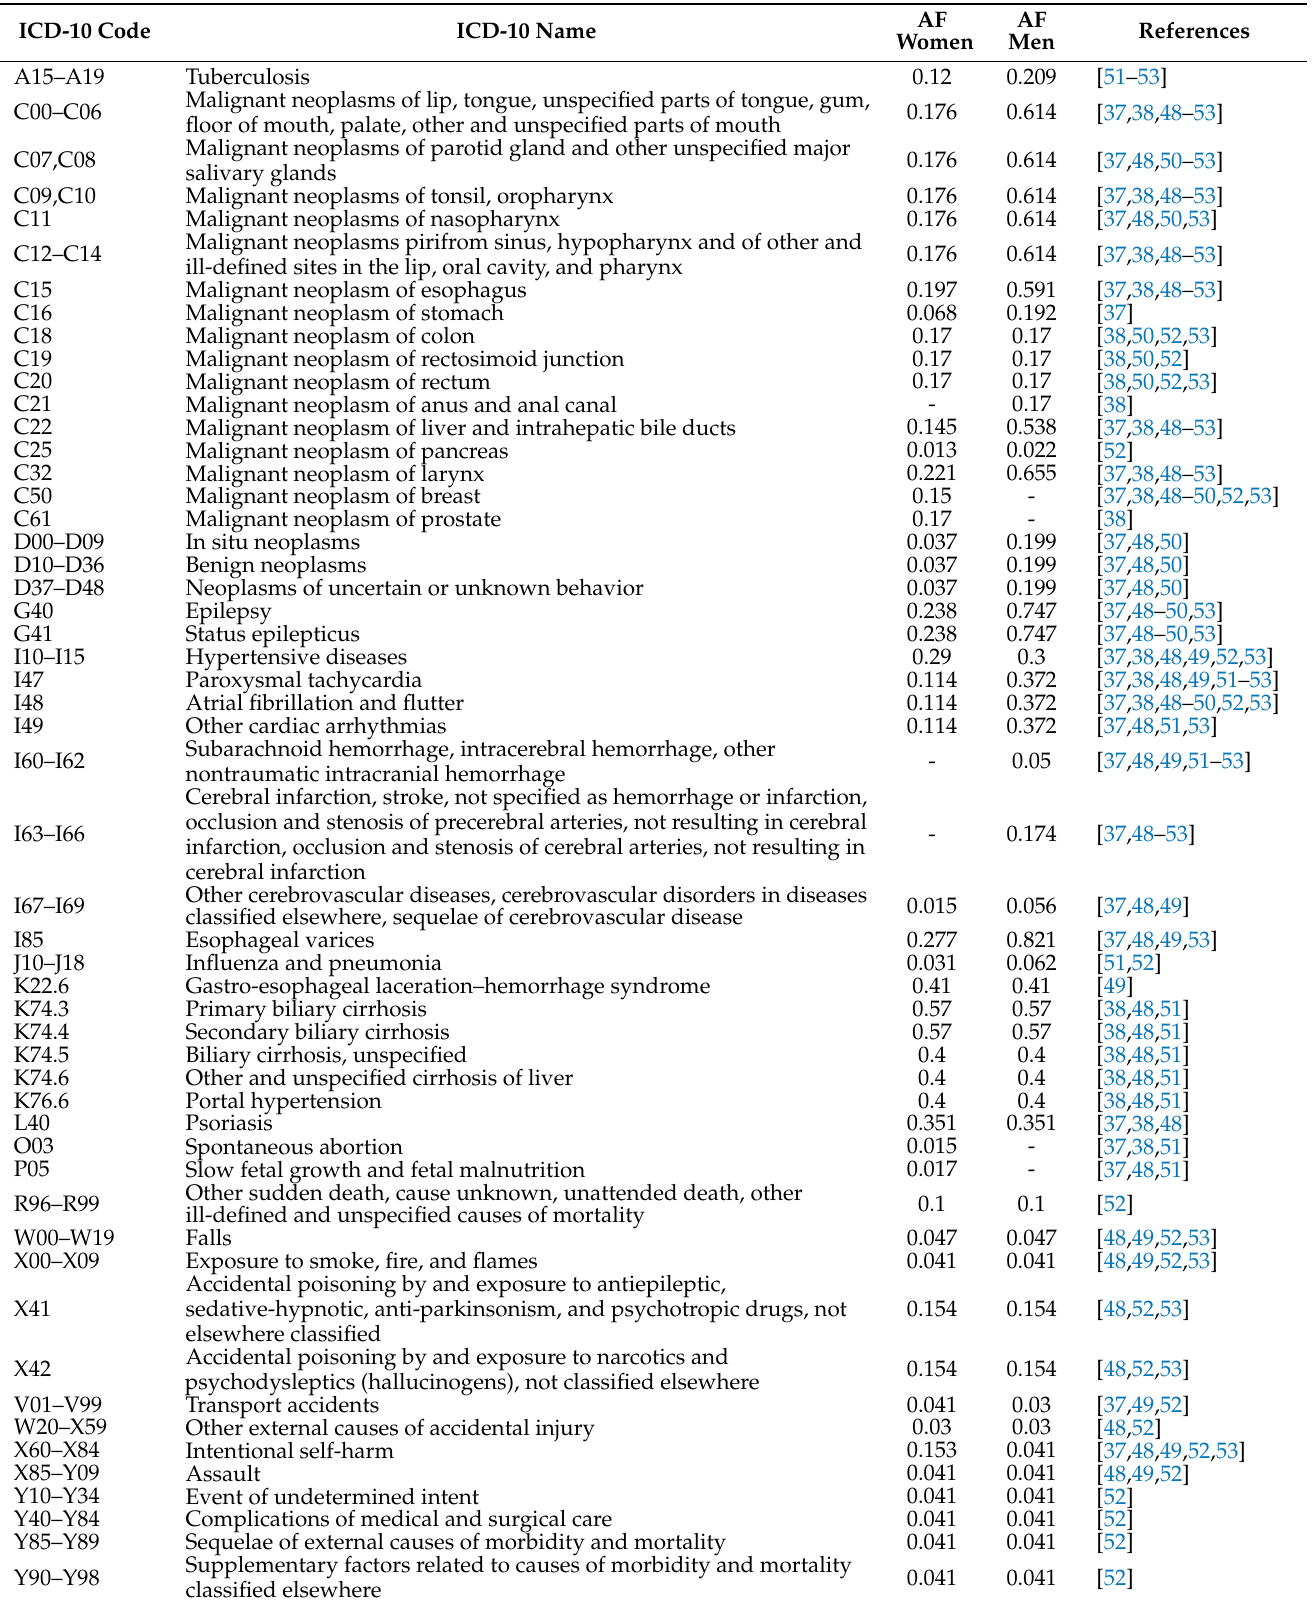
Table 2. Diagnoses partially attributable to